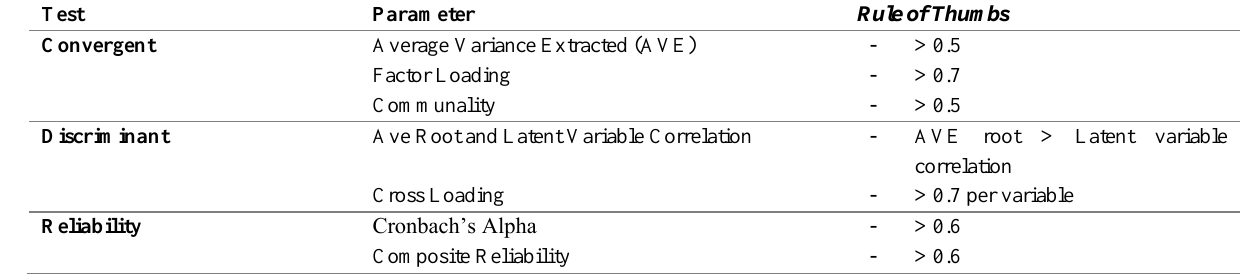
Table 1: Validity Test Parameters in the PLS Measurement Model